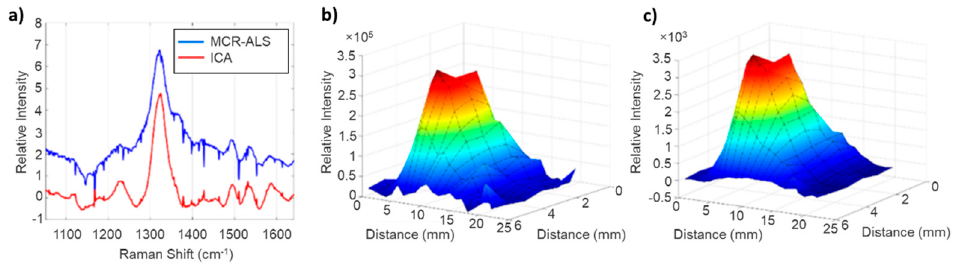
Figure 10. ( a ) Recovered SERS spectra for TMP standard, ( b ) concentration (chromatographic) profile for 5.00 × 10 − 6 mol · L − 1 TMP standard solution recovered by ( b ) MCR-ALS and ( c ) ICA.